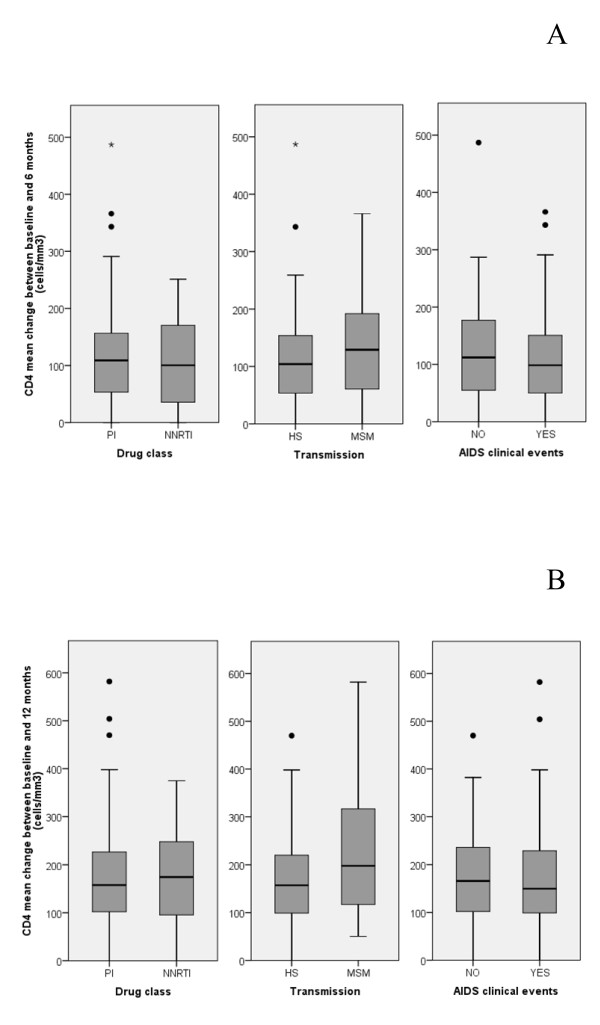
Changes of CD4+ T cells during time. CD4+ T cell mean absolute increase from baseline at 6 (A) and 12 months (B) by drug regimen (PIs- vs. NNRTIs- based), route of transmission, and clinical AIDS status at enrollment. Note: PIs: protease inhibitors; NNRTIs: non-nucleoside reverse transcriptase inhibitors; HS: heterosexual; MSM: men who have sex with men; IVDU: intravenous drug users.